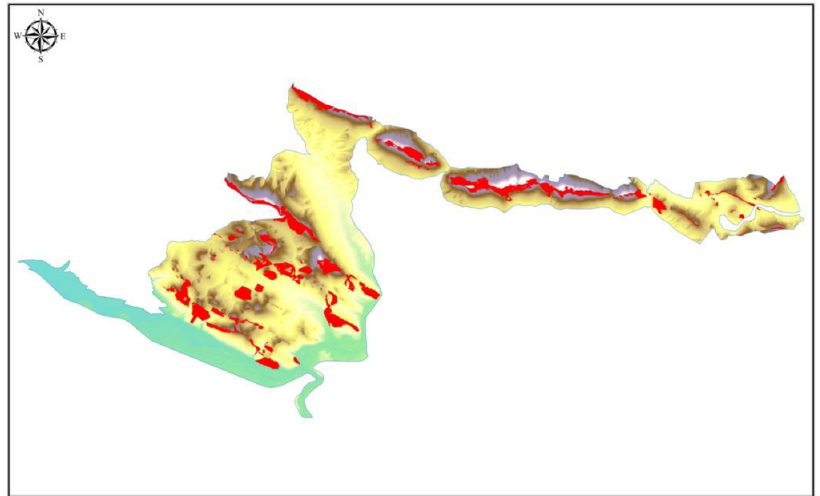
Figure 3. 9320 Thermomediterranean forests of Olea and Ceratonia (Iberian Peninsula, Balearic and Canary Islands). 832010 Querco rotundifoliae-Oleion sylvestris Barbero, Quézel and Rivas-Martínez in Rivas-Martínez, Costa, and Izco 1986. (Sierras de Almaden, Chillon and Guadalmez, red polygons). xxxxxx Asparago albi-Oleetum sylvestris Cantó, Ladero, Pérez Chiscano, and Rivas-Martí- nez in Rivas-Martínez et al. 2011. The map shows the thermophilous forests of wild olive, Olea europea ssp. sylvestris (Mill.) Hegi, in a single plant association in sites of community interest. Lon- gitude 4°50′24 W, latitude 38°46′31″ N (Almaden).